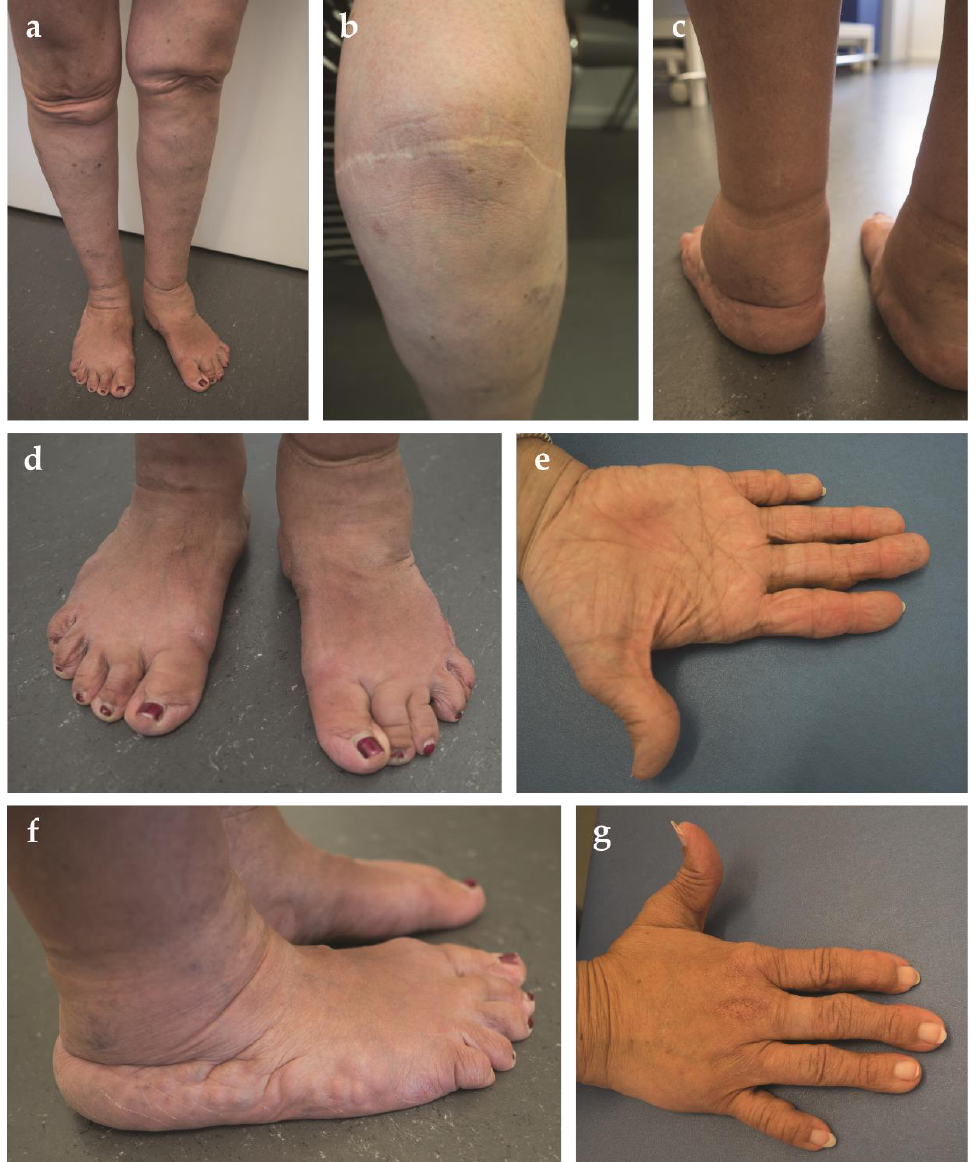
Figure 2. Clinical features of the patient. ( a ) Redundant and sagging skin on both knees; ( b ) widened scar on the left knee after surgery. No atrophic features are present; ( c ) chronic ankle edema in the absence of cardiac failure; ( d ) plane flat feet with broad forefeet and short digits; ( e ) increased palmar skin creases; ( f ) piezogenic papules; ( g ) short and broad acrogeric hands. Note the hyperextensibility of the thumb.